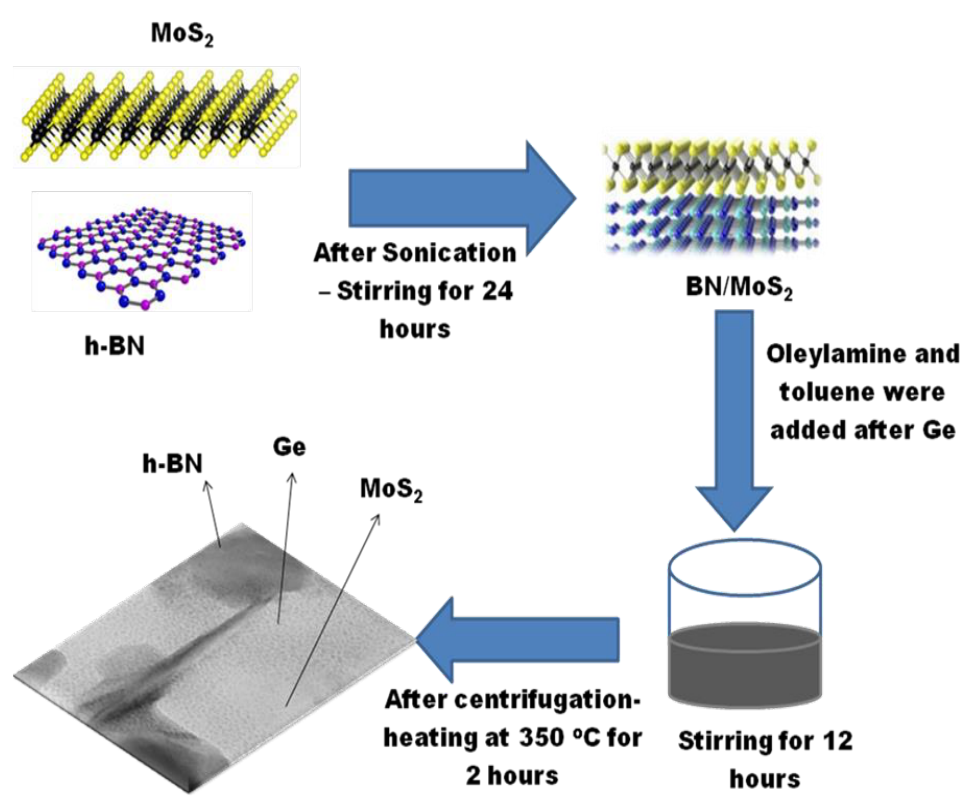
Figure 1. Formation mechanisms of Ge-modulated h-BN/MoS 2 .